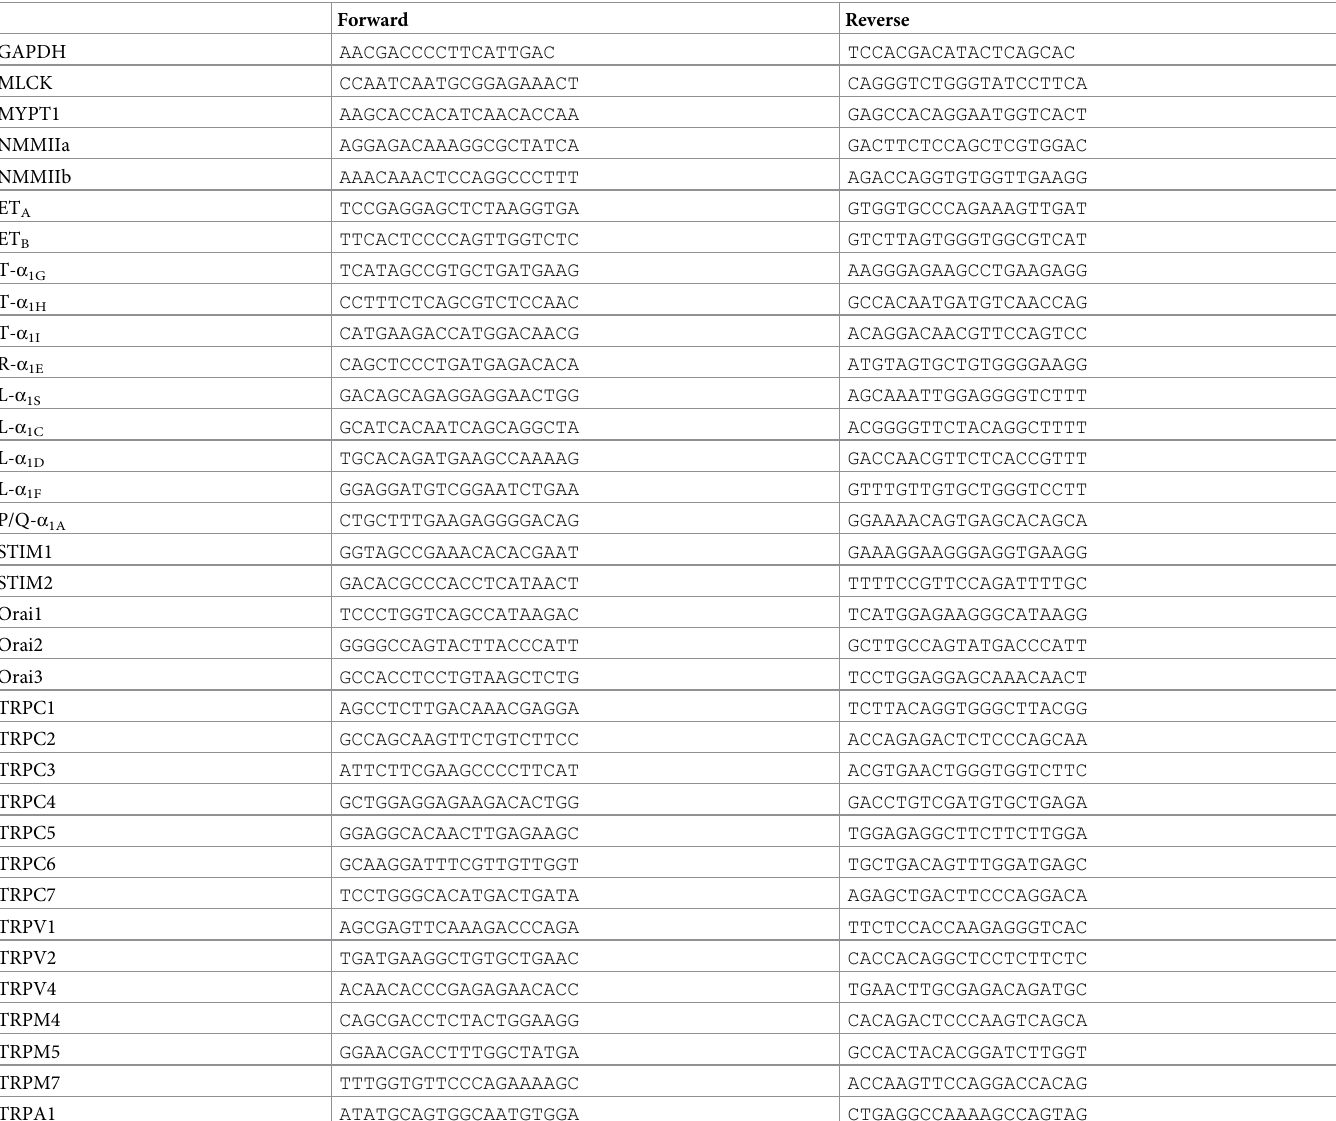
Table 1. Primers used for